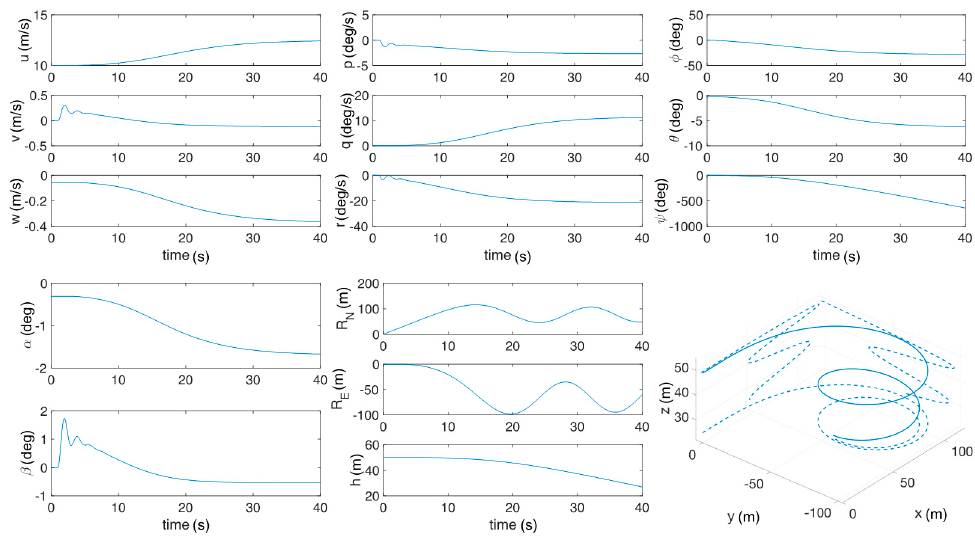
Figure 10. UAV response to the unit step rudder.